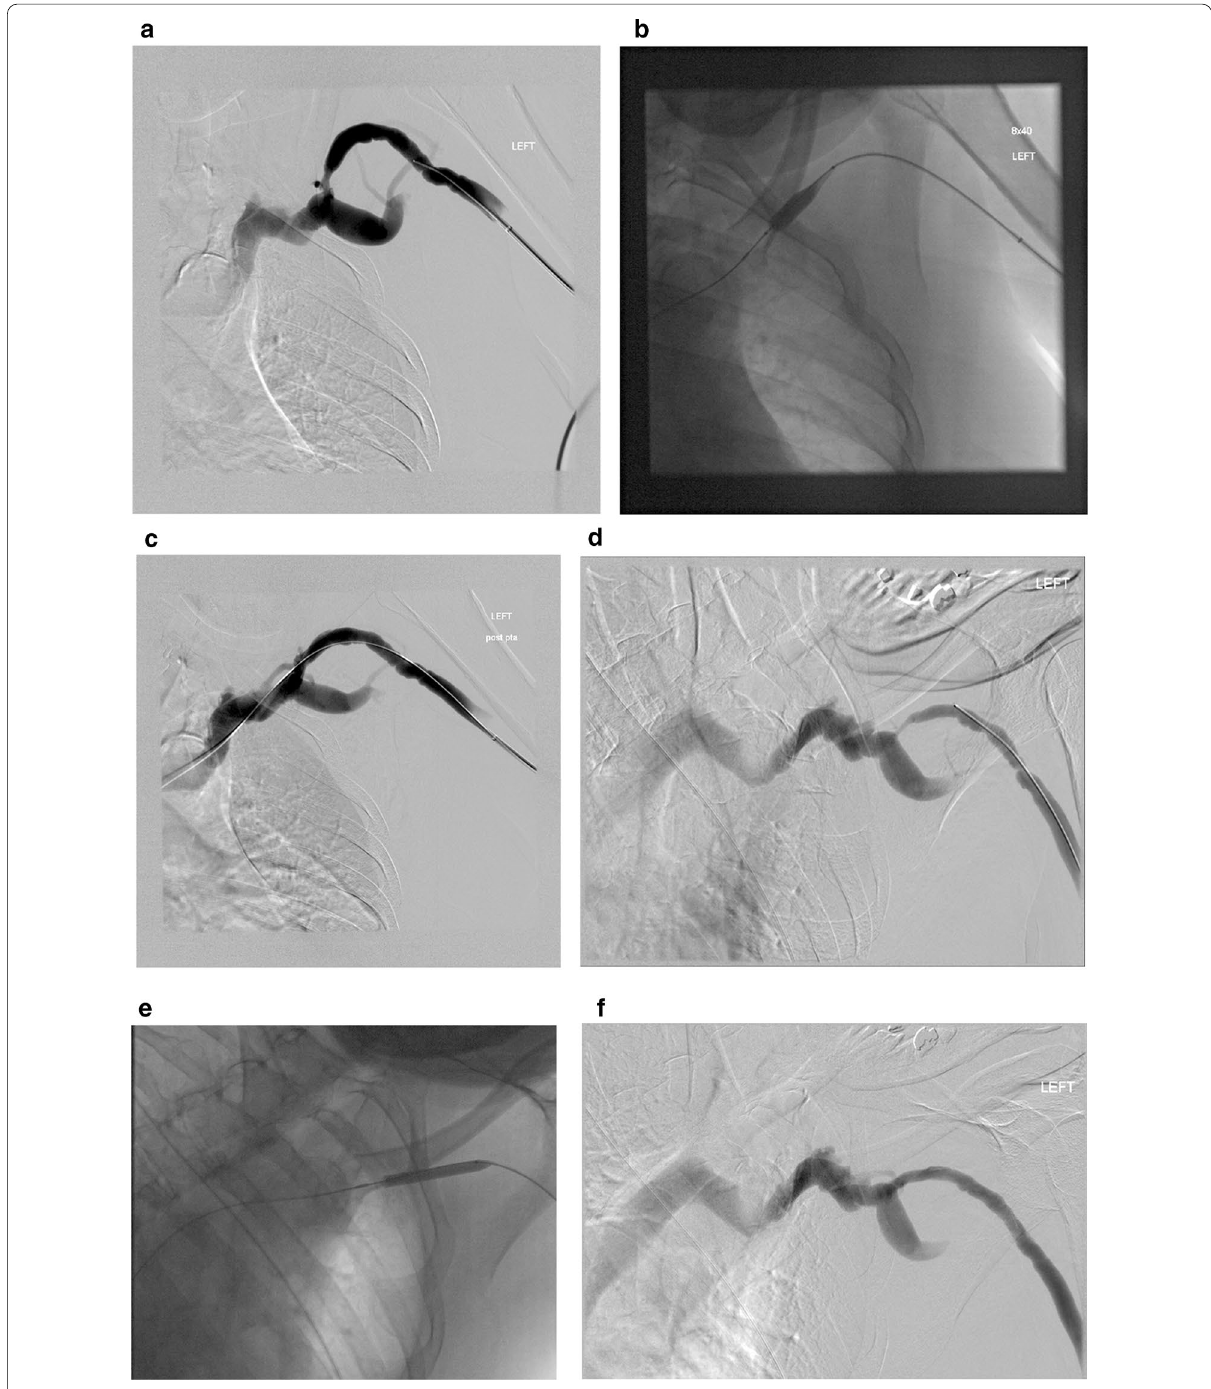
Fig. 1 a Antegrade diagnostic venogram in left AVF showing tight stenosis at the terminal arch. b Angioplasty at the terminal arch using 8 mm 4 cm balloon. c Post-angioplasty venogram showing no significant residual stenosis at the terminal arch. d Antegrade diagnostic venogram × in Left AVF after 5 months showing recurrent tight stenosis at the terminal arch. e Angioplasty at the terminal arch using 8 mm Post-angioplasty venogram showing no significant residual stenosis at the terminal